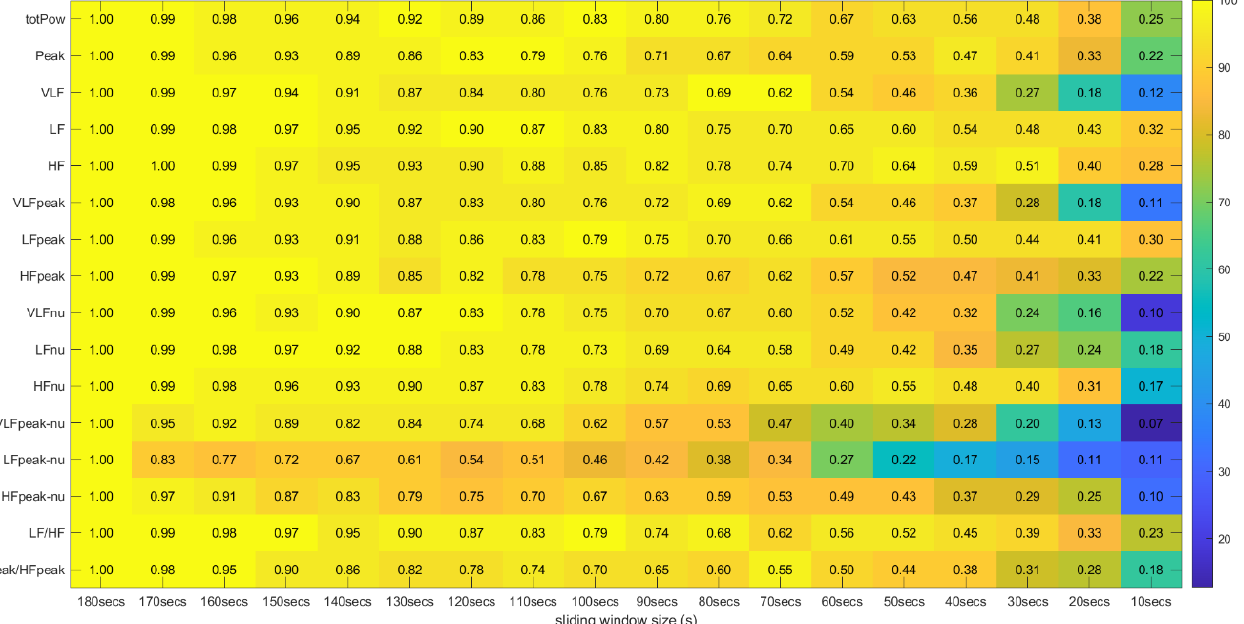
Figure 11. Spearman’s Correlation Test (Frequency Domain) ** Heatmap Colors: Percentage of runs where there exists significant correlation between the feature (row) extracted using the respective window size (column) and the same feature obtained using the 180-second sliding window. Cell Values: Means, across the different runs, of the correlation coefficients between the feature (row) extracted using the respective window size (column) and the same feature obtained using the 180-second sliding